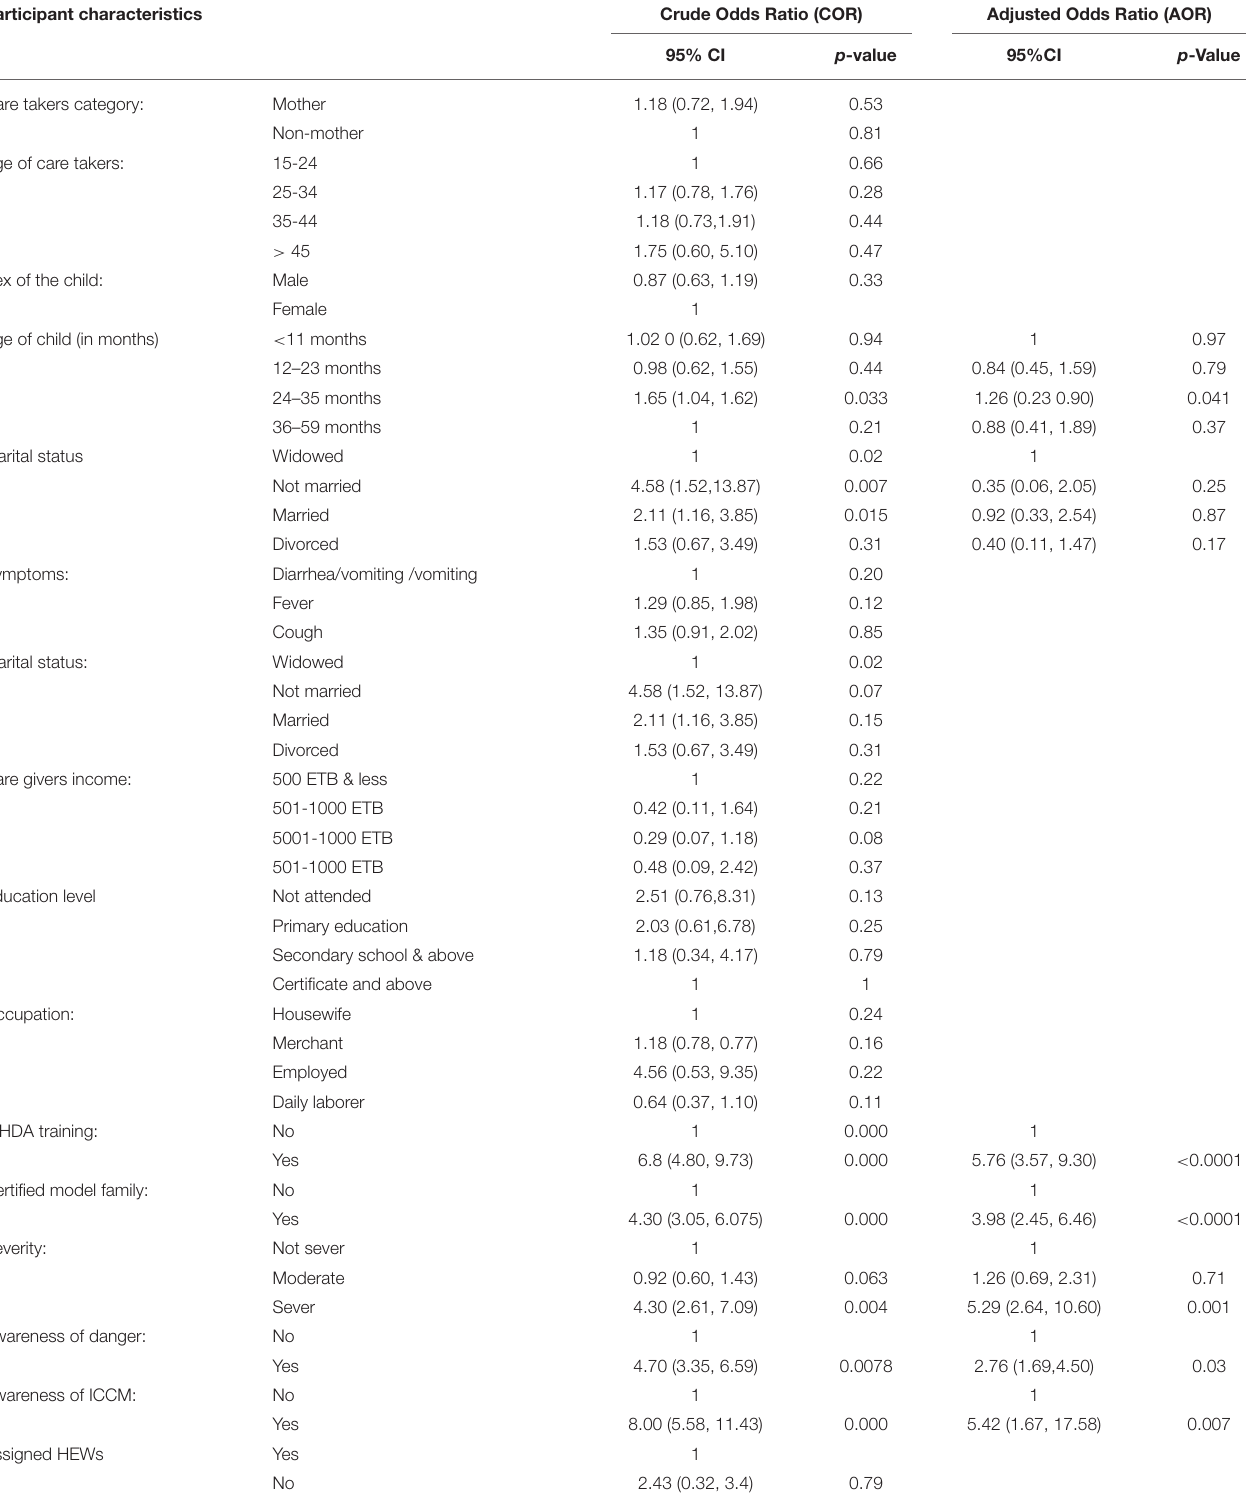
TABLE 4 | Caretakers related factors associated with Integrated community case management (ICCM) utilization: a result from binary and multivariate logistic regression analysis in Dandi woreda, West Shewa, Ethiopia, 2022. Participant